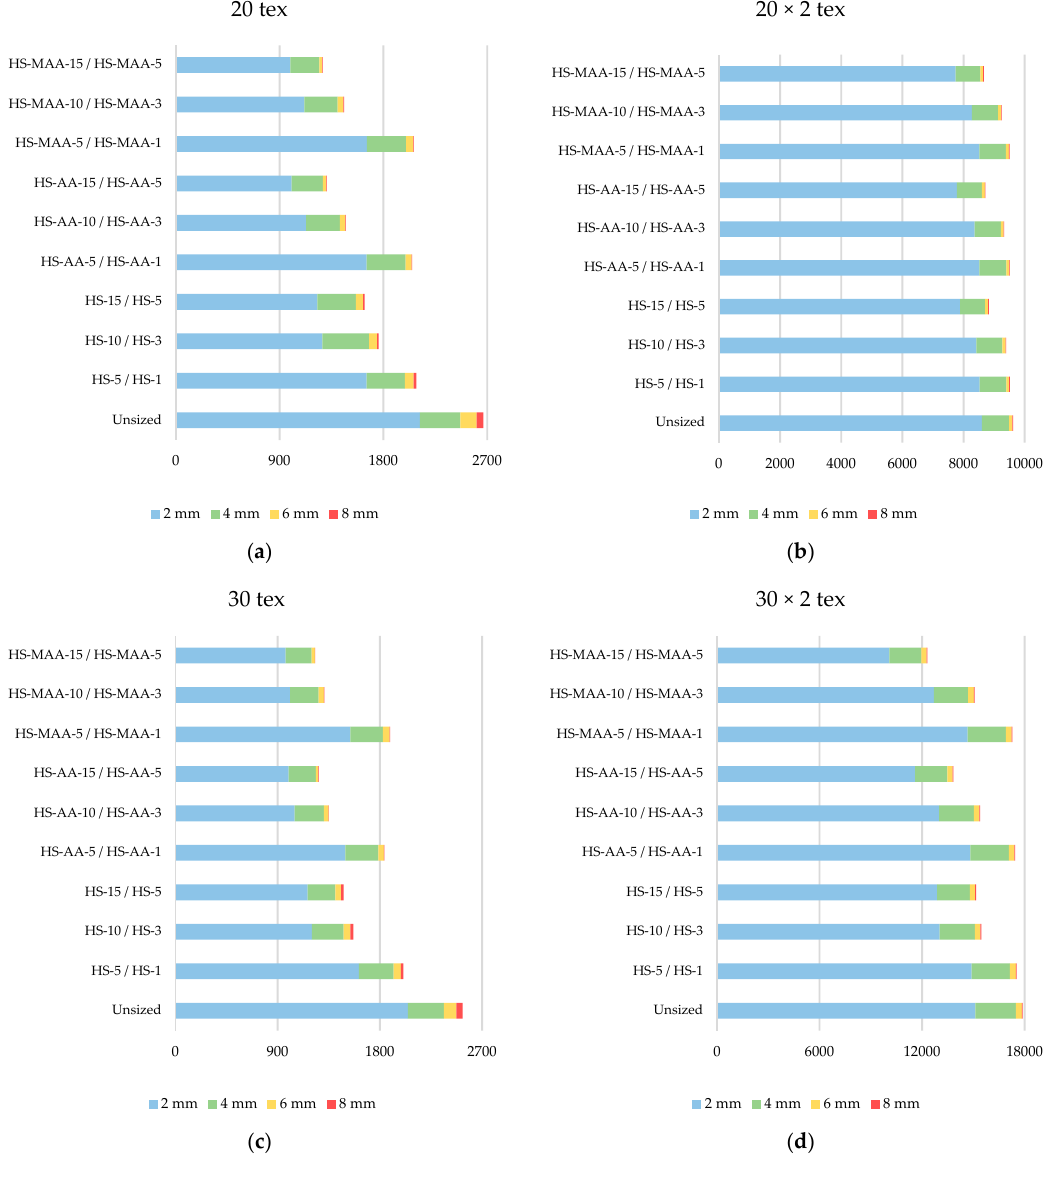
Figure 4. Hairiness of the yarn in the sizing process: ( a ) 20 tex single yarn, ( b ) 30 tex single yarn, ( c ) 20 × 2 tex ply yarn, ( d ) 30 × 2 tex ply yarn.